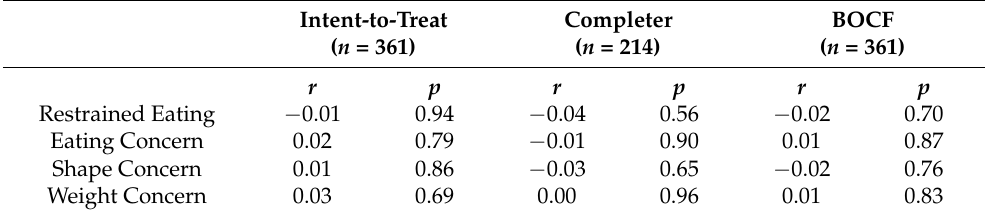
Table 3. Exploratory post-hoc analysis: Correlations between ChEDE-Q8 subscales and treatment success ( ∆